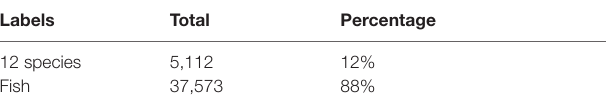
TABLE 4 | The total number of autonomously labelled species and the number of fish autonomously identified for manual labelling using the 12 species + fish model.